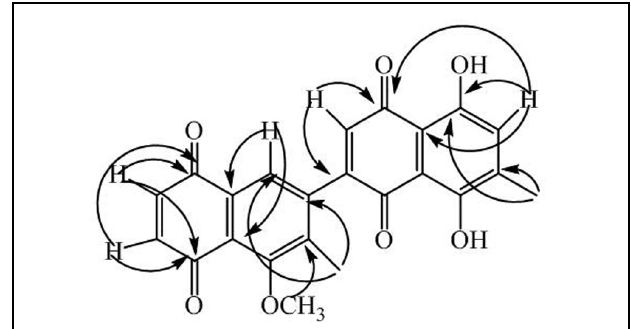
FIGURE 3 | Key HBMC correlations of compound 2.